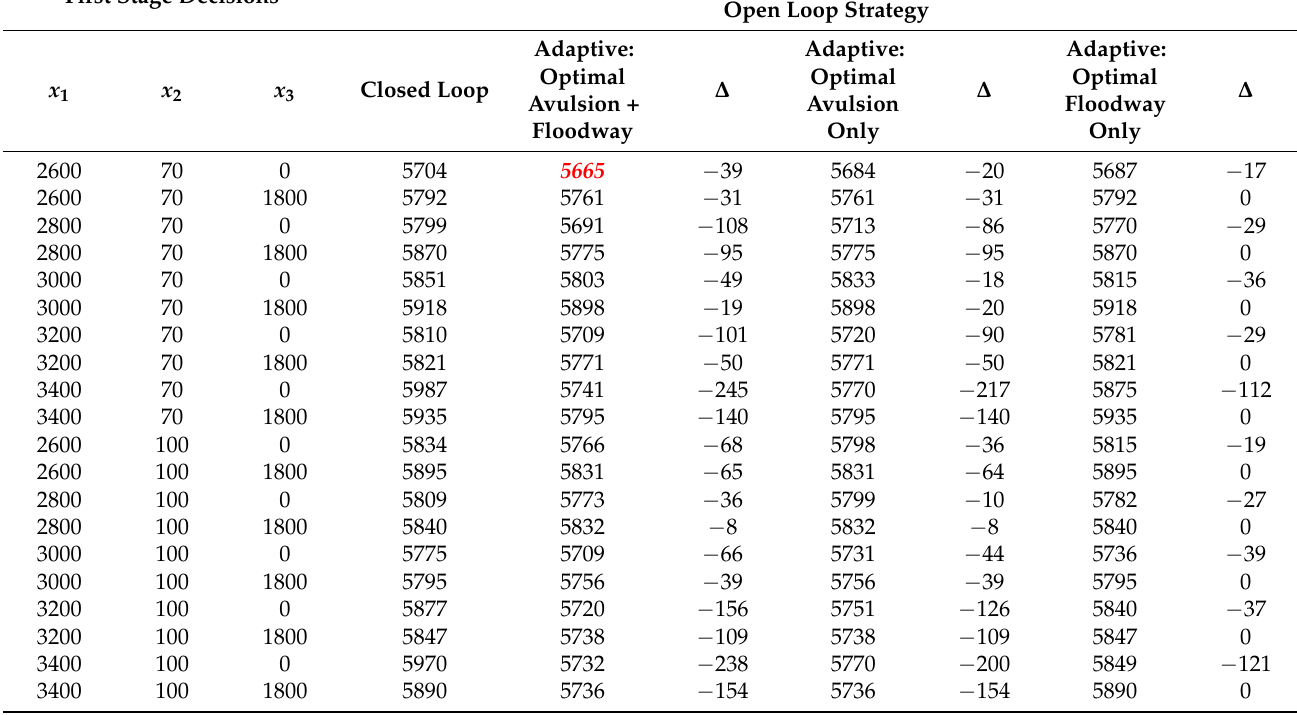
Table 6. Summary of expected cost (across scenarios) of open- and closed-loop decisions for each of the first stage decisions (Bold italicized red text indicates the optimal